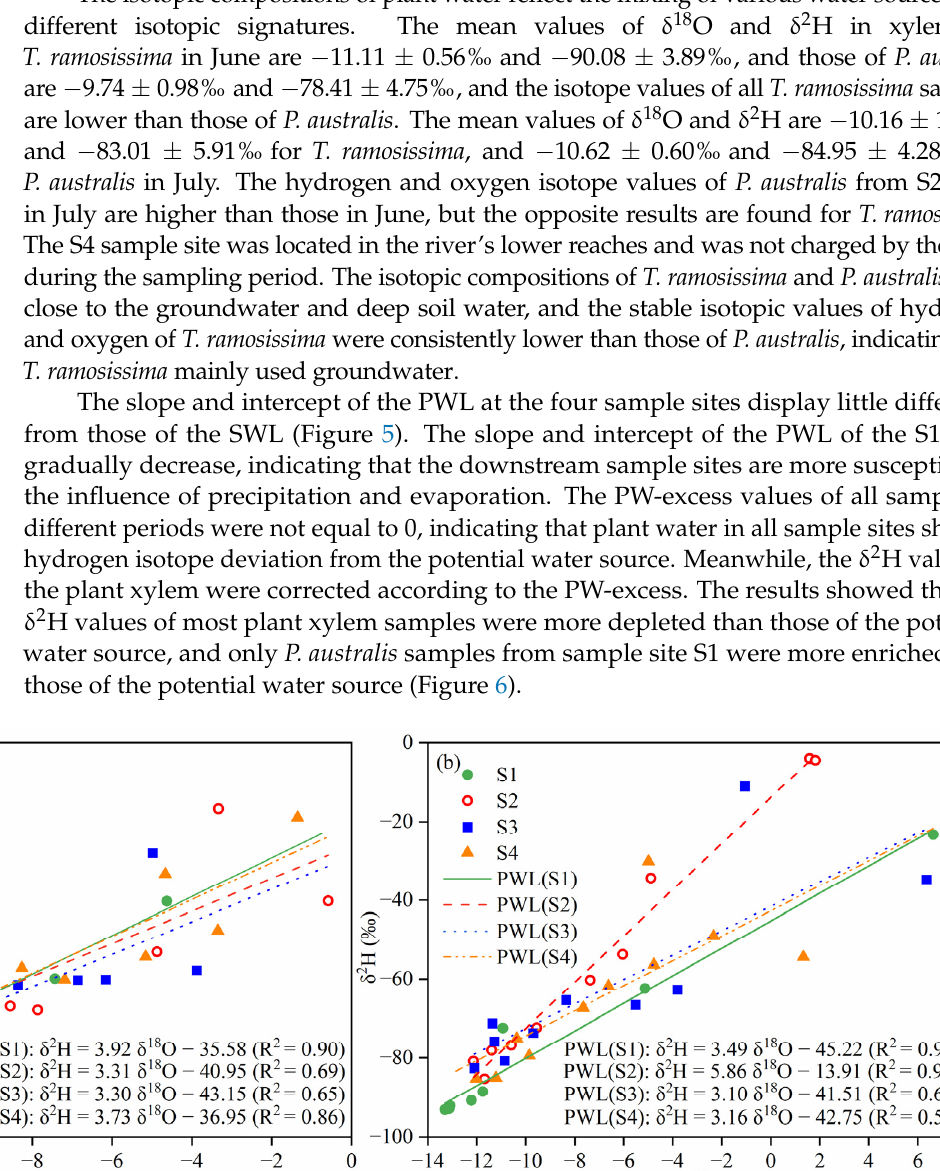
Figure 6. δ 2 H values of plant xylem after PW-excess corrections. δ 2 H o represents the original δ 2 H value measured experimentally, and δ 2 H m represents the δ 2 H value corrected by PW-excess. 3.3. Contribution Percentages of Potential Water Sources to Plant Water In our study, δ 18 O and corrected δ 2 H were used to calculate the contribution percent- ages of potential water sources to plant water. Based on the results of MixSIAR model calculations, the potential water contributions of sites S1–S4 are shown in Figure 7. The plants at sample sites S2–S4 mainly used groundwater and deep soil water, with mean values of 34.5 ± 5.1% and 32.2 ± 1.9% utilization, respectively. However, the least used was shallow soil water, with a mean value of only 12.4 ± 2.8%. Chen et al. [56] found that ri- parian plants under intermi tt ent ecological water conveyance in the Tarim and Black